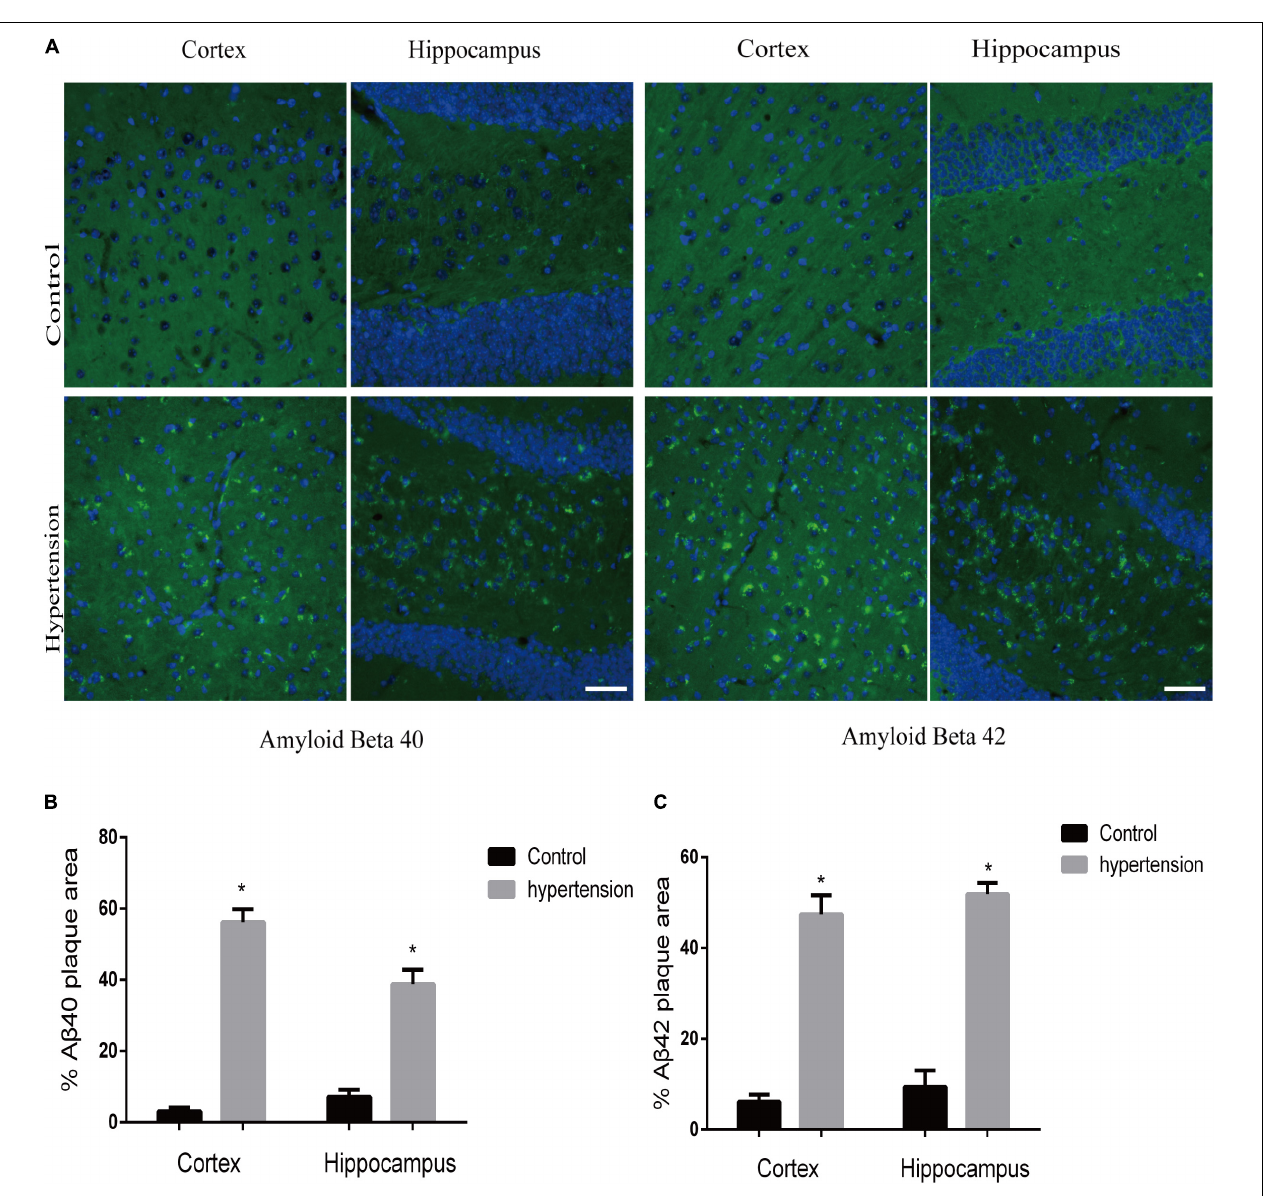
FIGURE 2 | A β 40 and A β 42 deposition in the brain. After 30 days of angiotensin II treatment in middle-aged mice, the brain slices were subjected to immunofluorescence staining with the anti-A β 40 (green) or the anti-A β 42 (green) antibody and DAPI (blue) to observe β -amyloid deposition in the cortex and hippocampus. (A) Representative images of A β 40 or A β 42 deposition in the control and hypertension groups (immunofluorescence, × 40, scale bar = 50 µ m). (B,C) Histograms comparing the percentage of A β 40 or A β 42 plaque area in the cortex and hippocampus of the control and hypertension groups ( n = 7 per group). Data are expressed as the means ± SD. * p <